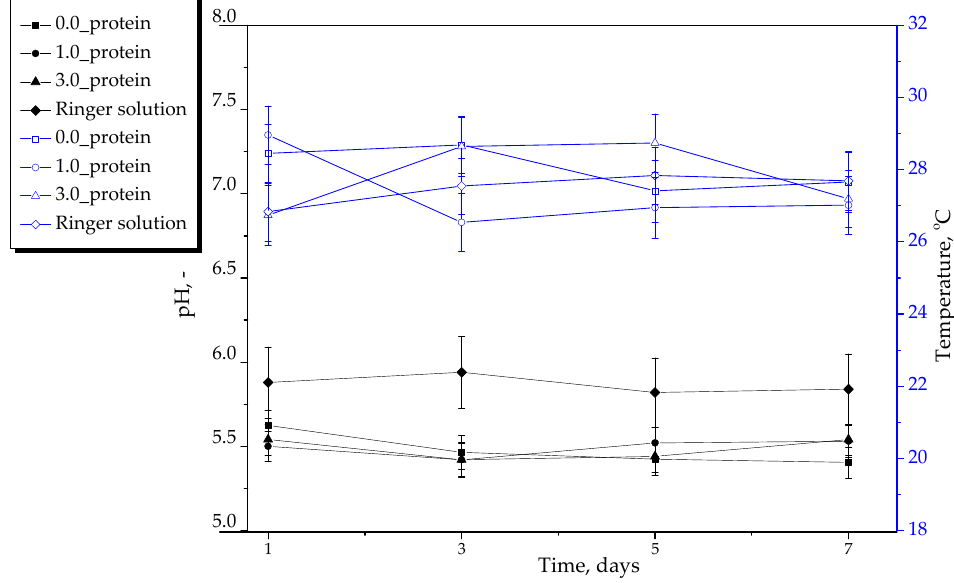
Figure 7. Results of hydrogels’ incubation in Ringer liquid ( n —number of repetitions, n =